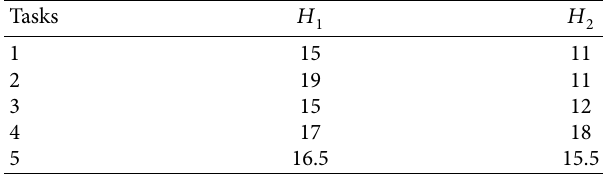
Table 8: The related crisp numbers of the processing times.